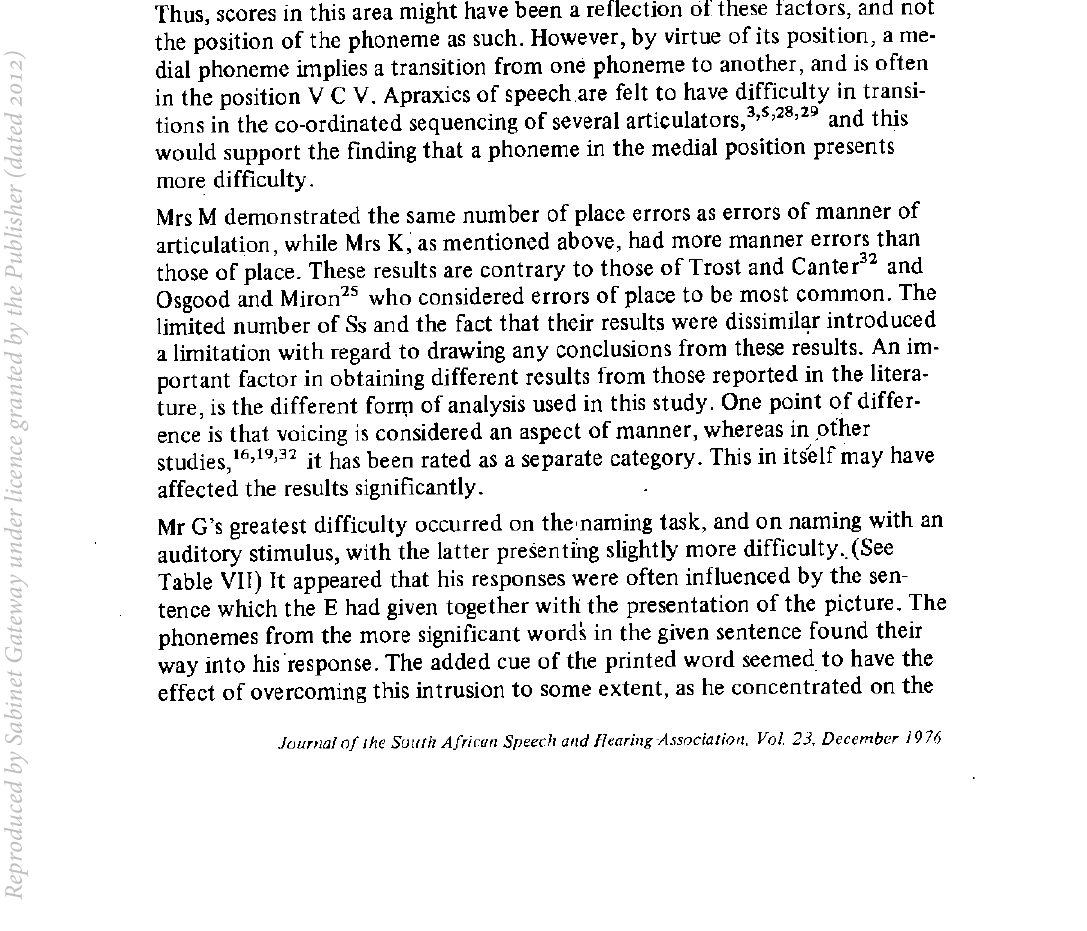
TABLE VI: Total distance scores expressed as the percentage of incorrect . features : Mrs